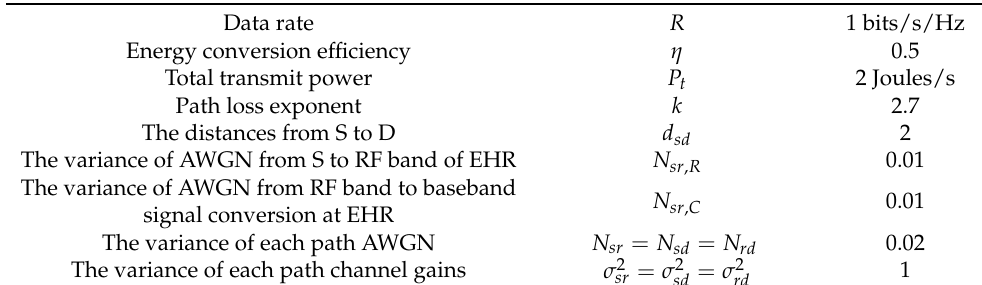
Table 1. Used parameters list.